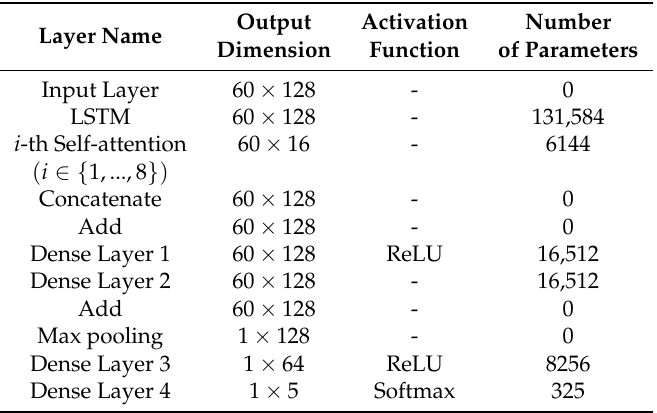
Table 3. Details of proposed